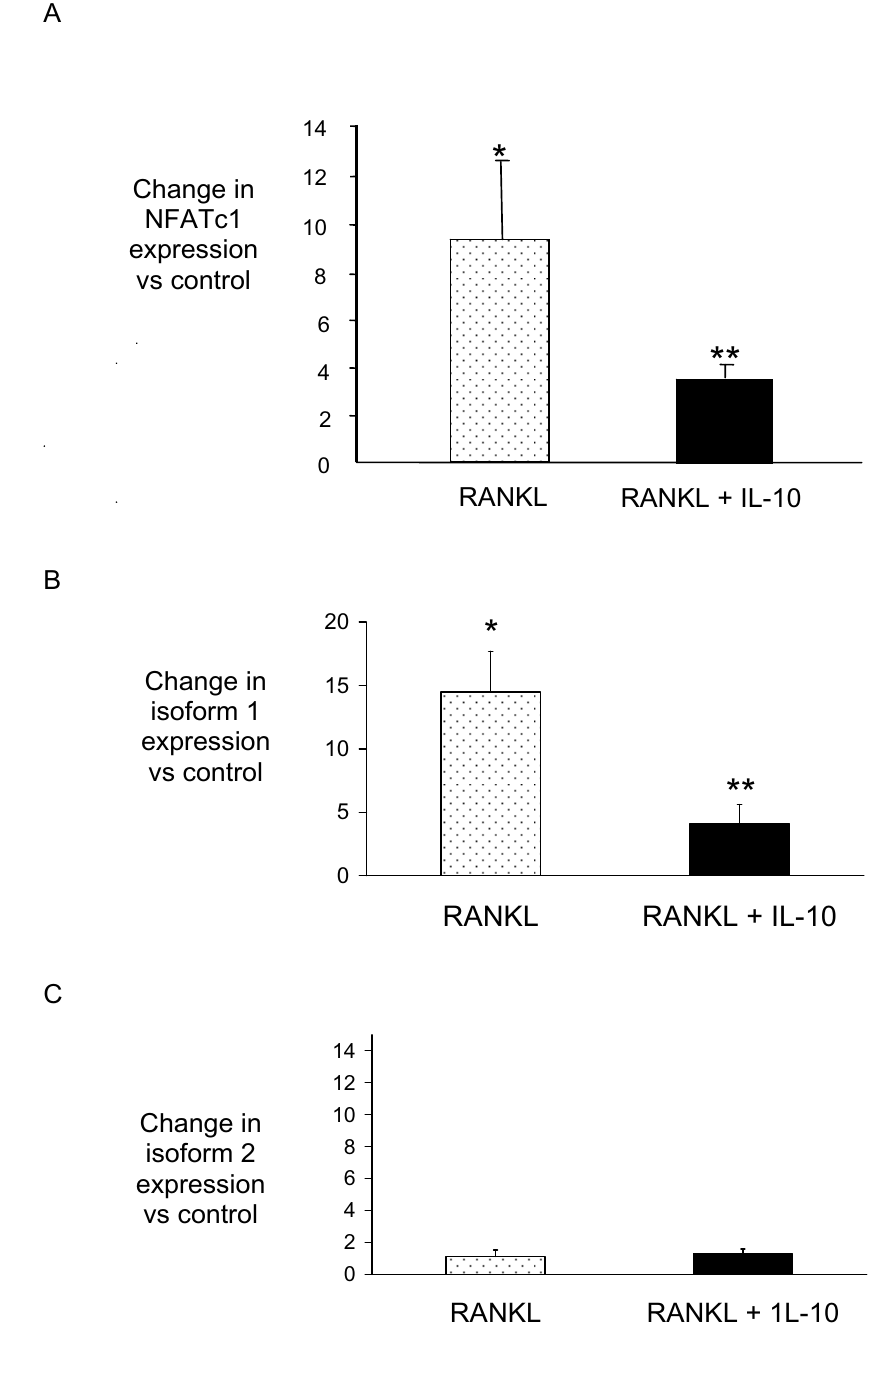
Figure 2 NFATc1 expression is suppressed by IL-10 . RAW264.7 cells were incubated with cytokines (RANKL 50 ng/ml and IL-10 50 ng/ml) for 2 days and total RNA extracted. NFATc1 expression was assessed using quantitative PCR using specific primers recognising both isoforms (A) isoform 1 (B) or isoform 2 (C). Results are expressed as the mean ± SEM for each group from three separate experiments normalised for β -actin. * p < 0.05 versus control, ** p < 0.05 versus RANKL-treated